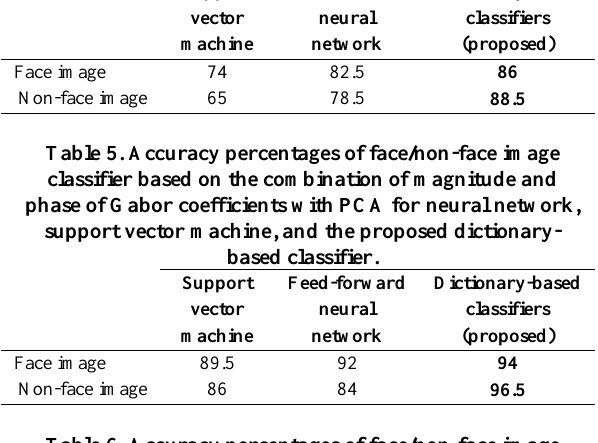
Table 6. Accuracy percentages of face/non-face image classifier based on PCA coefficients for neural network classifications, support vector machine, and the proposed dictionary-based